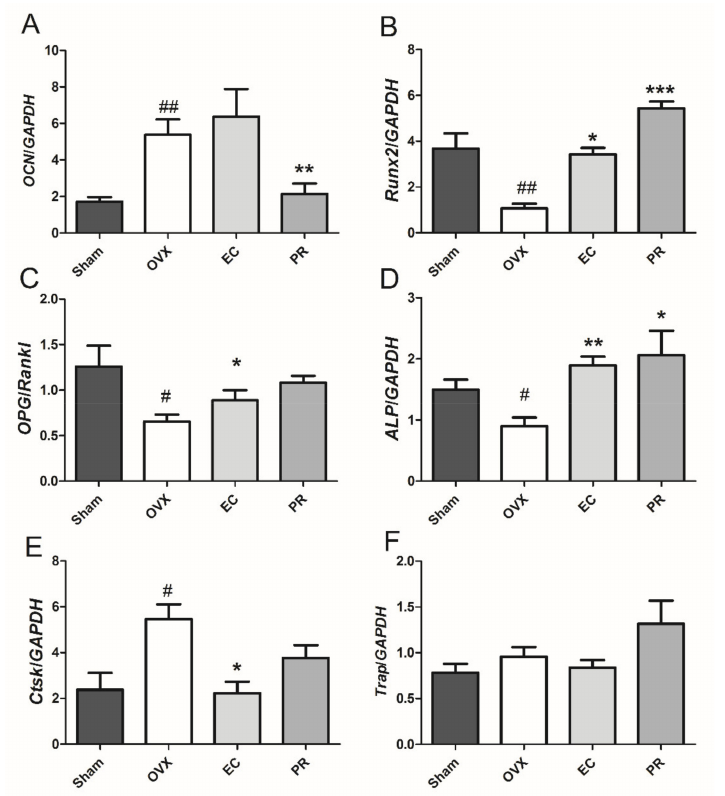
Figure 1. Effects of Erythrinae Cortex (EC) extract on bone specific mRNA expression in rat tibia. Three-month old SD rats were subjected to the following treatment for 12 weeks after ovariectomy: Sham, Sham-operated, vehicle-treated; OVX, ovariectomized, vehicle-treated; PR, ovariectomized, Premarin-treated (0.13 mg/kg); EC, ovariectomized, EC extract-treated (600 mg/kg). ( A ) OCN , osteo- calcin; ( B ) Runx2 , runt-related transcription factor 2; ( C ) OPG / Rankl , OPG , osteoprotegerin; Rankl , receptor activator of nuclear factor κ B ligand; ( D ) ALP , alkaline phosphatase; ( E ) Ctsk , cathepsin K; ( F ) Trap , tartrate-resistant acid phosphatase 5; GAPDH , glyceraldehyde 3-phosphate dehydrogenase. Results were expressed as mean ± SEM ( n = 6). # p < 0.05, ## p < 0.01 vs. Sham; * p < 0.05, ** p < 0.01, *** p < 0.001 vs.